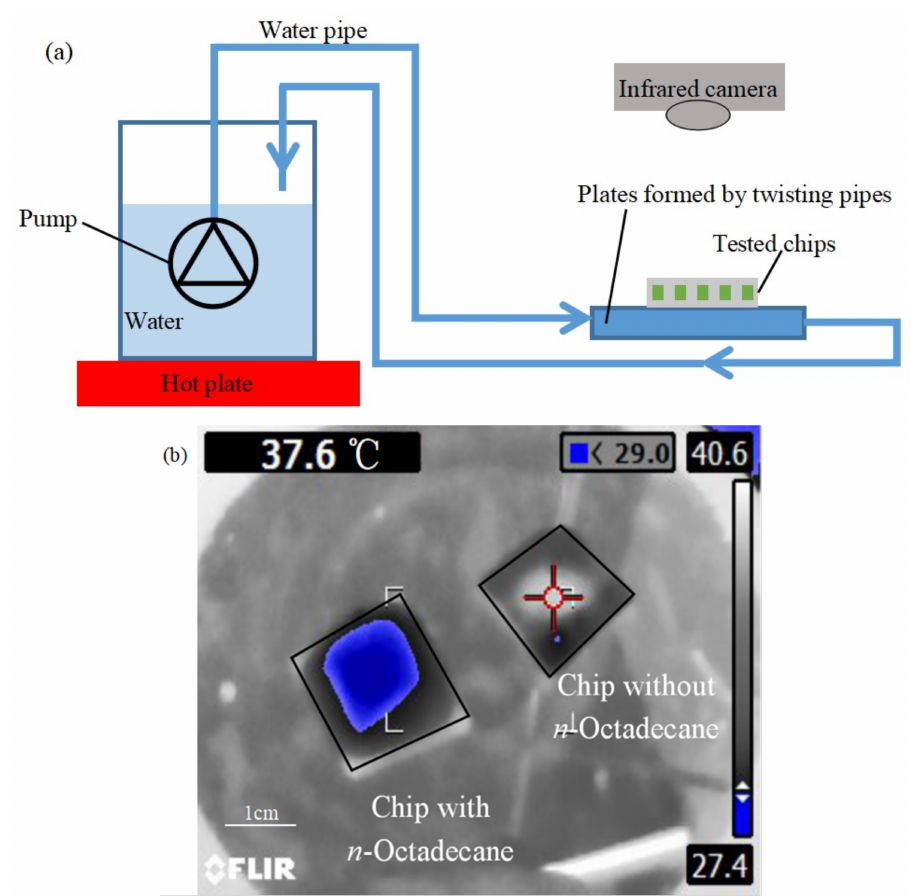
Figure 12. ( a ) A schematic diagram of the test system with a hot water circulation system to